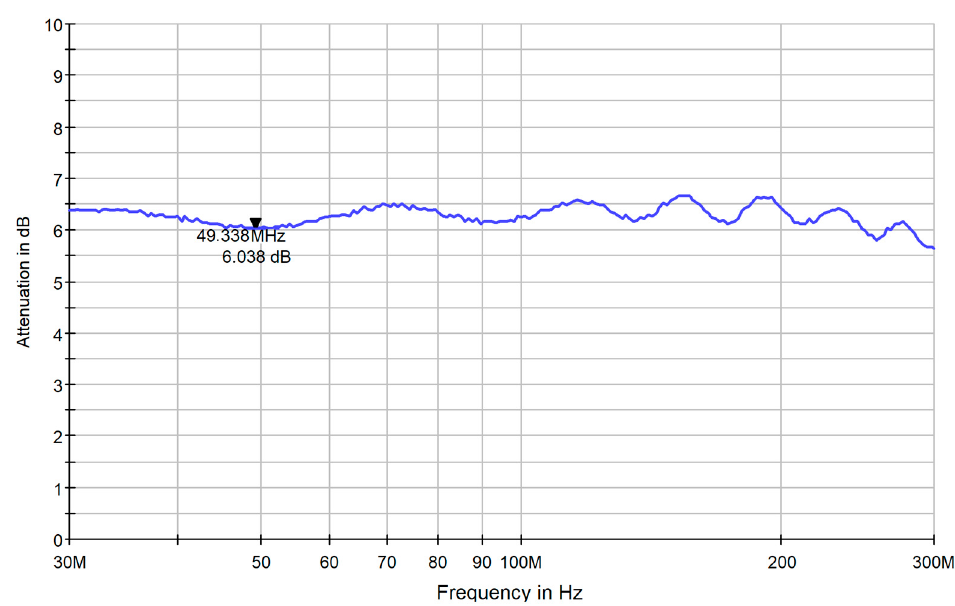
Figure 5. Frequency characteristics of the voltage division factor for Ericka Fiedler’s CDN-M2 net- work.